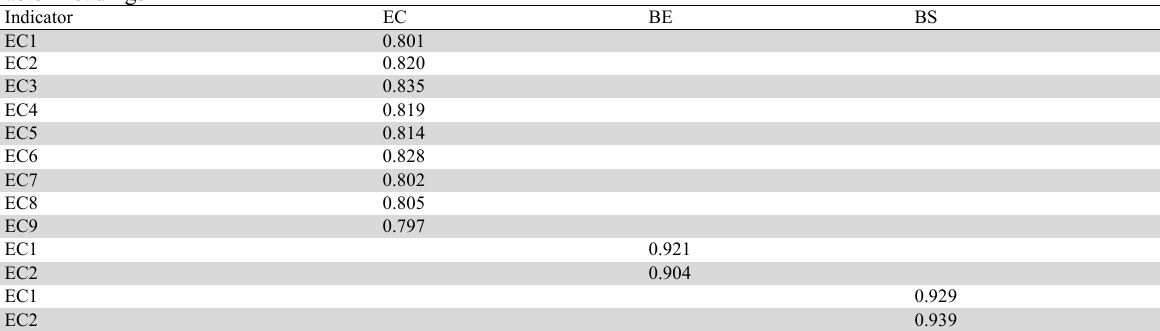
Factor Loadings